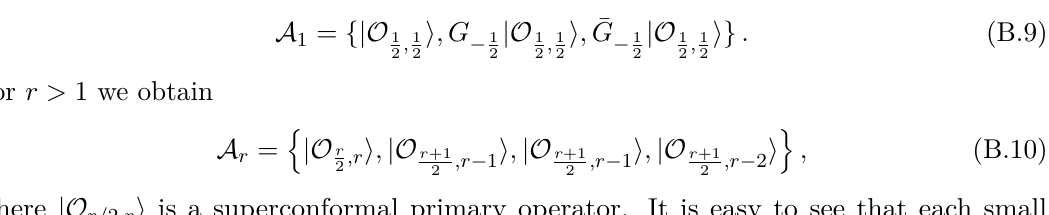
Figure 4 . Schematic representation of the long-multiplet L r , see [70] for more details. The arrows going to the left (right) represent the action of G a are shown. Operators in the same line have the same conformal dimension h and the dimension grows by half when moving to the next line